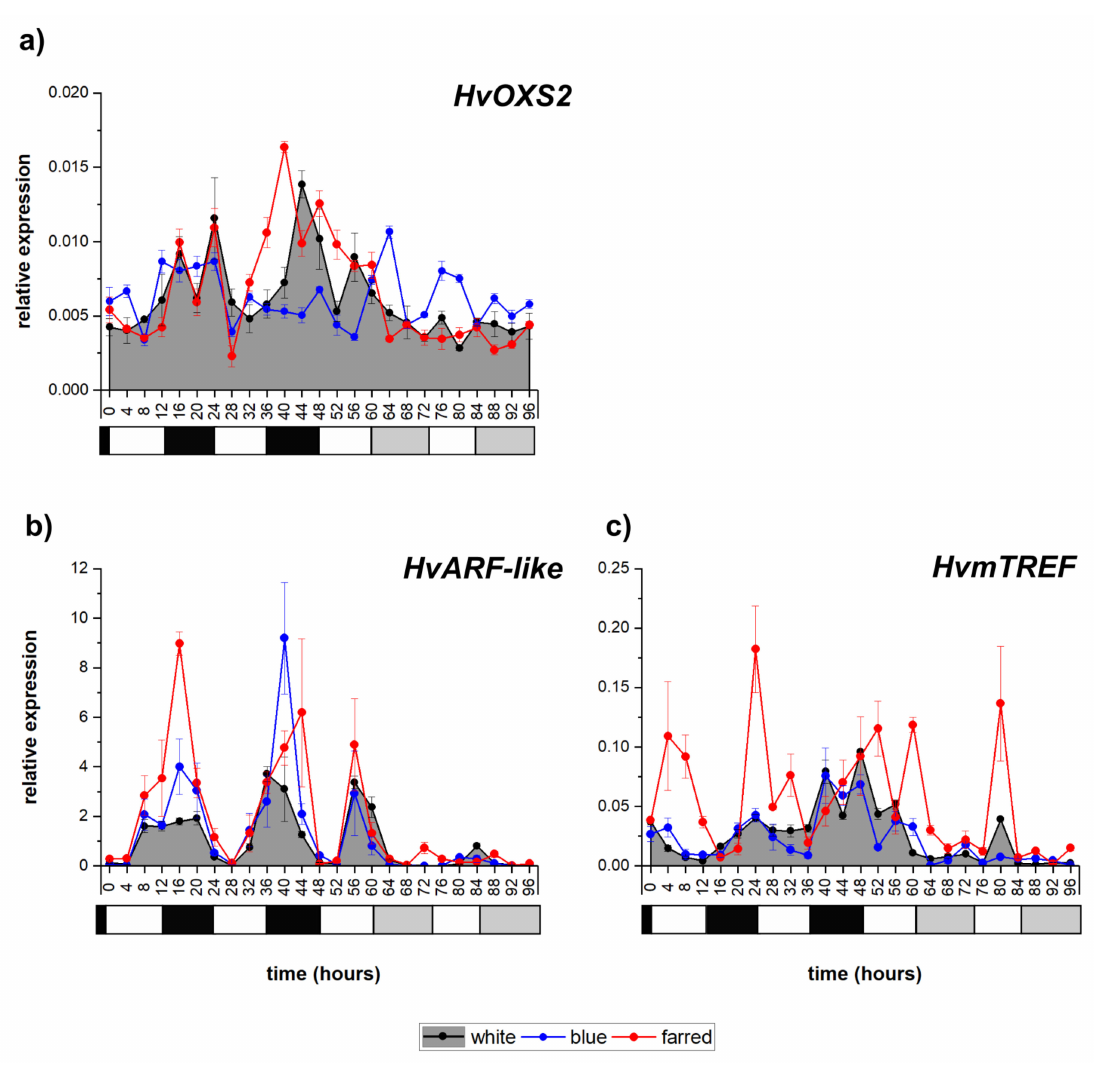
Figure 3. Expression patterns of HvOXS2 ( a ), HvARF-like ( b ) and HvmTREF ( c ) transcription factor coding genes under white, blue and far-red light illumination. Calculating methods and the legends of graphs are the same as described in Figure 1. The following significant differences were calculated at p ≤ 5% level: HvOXS2 - 0.00059; HvARF-like —0.37; HvmTREF